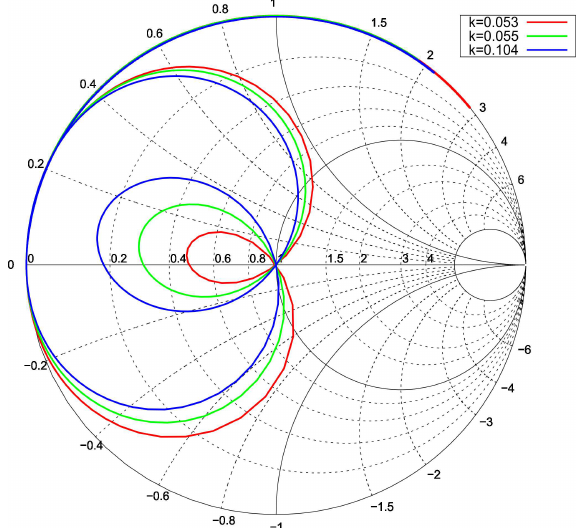
Figure 5. Exemplary s 11 characteristics of the proposed filter for three values of coupling coefficient: k = 0.053 ( C 1 = 2.85 pF, L 1 = 8.8 nH, L 2 = 2.66 nH, L 3 = 0.34 nH), k = 0.055 ( C 1 = 3.15 pF, L 1 = 8.8 nH, L 2 = 2.66 nH, L 3 = 0.3 nH), k = 0.104 ( C 1 = 3 pF, L 1 = 8.8 nH, L 2 = 1.5 nH, L 3 = 0.6